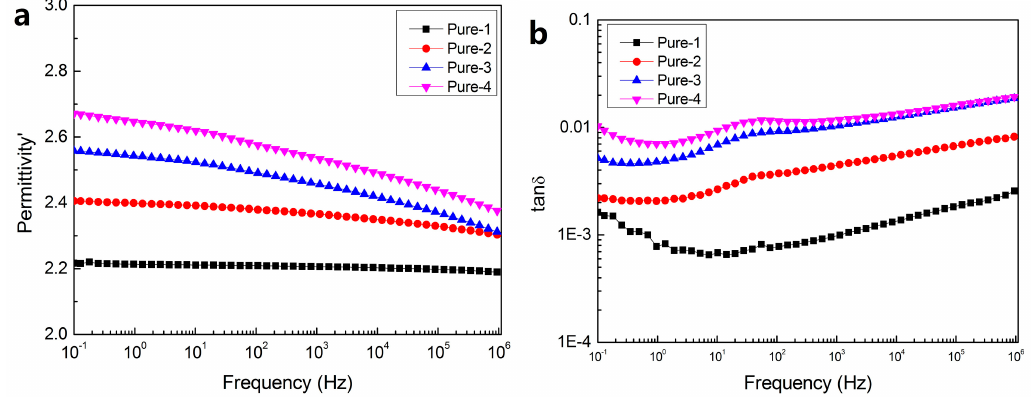
Figure 5. Dielectric spectrum of pure LDPE for dielectric constant ( a ) and dielectric loss ( b ).